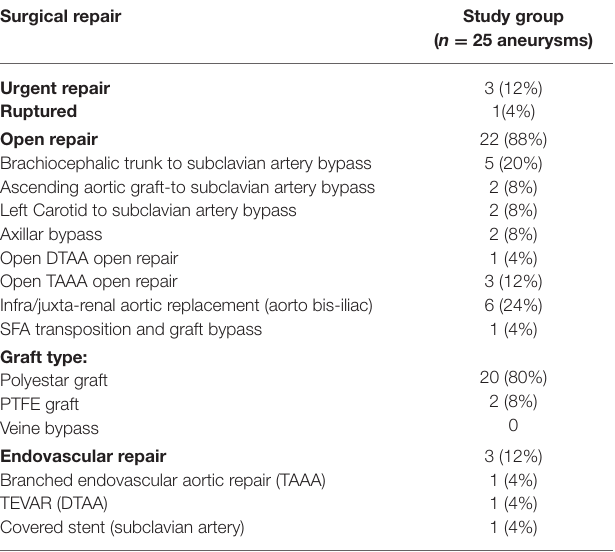
TABLE 2 | Surgical repair of aneurysms in the study group ( n = 25 aneurysms). Surgical repair